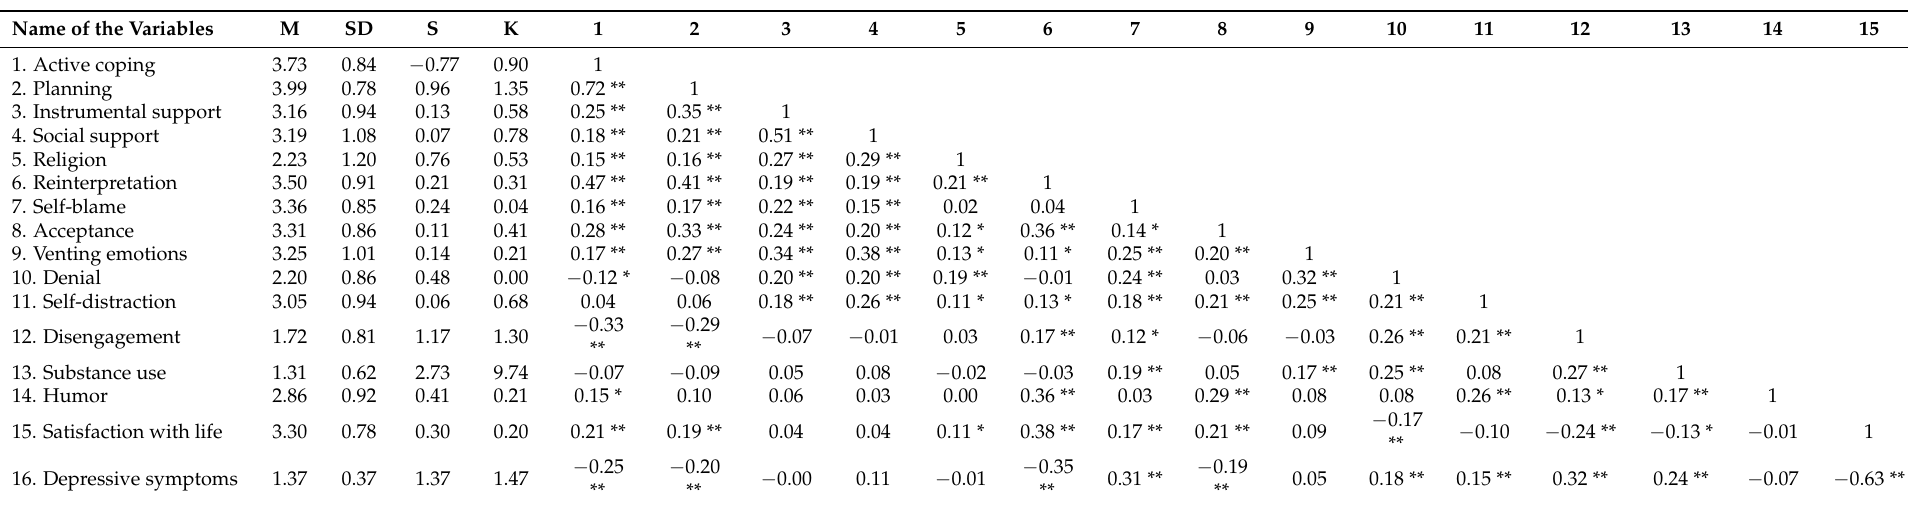
Table 2. Descriptive analysis and correlations between the variables being